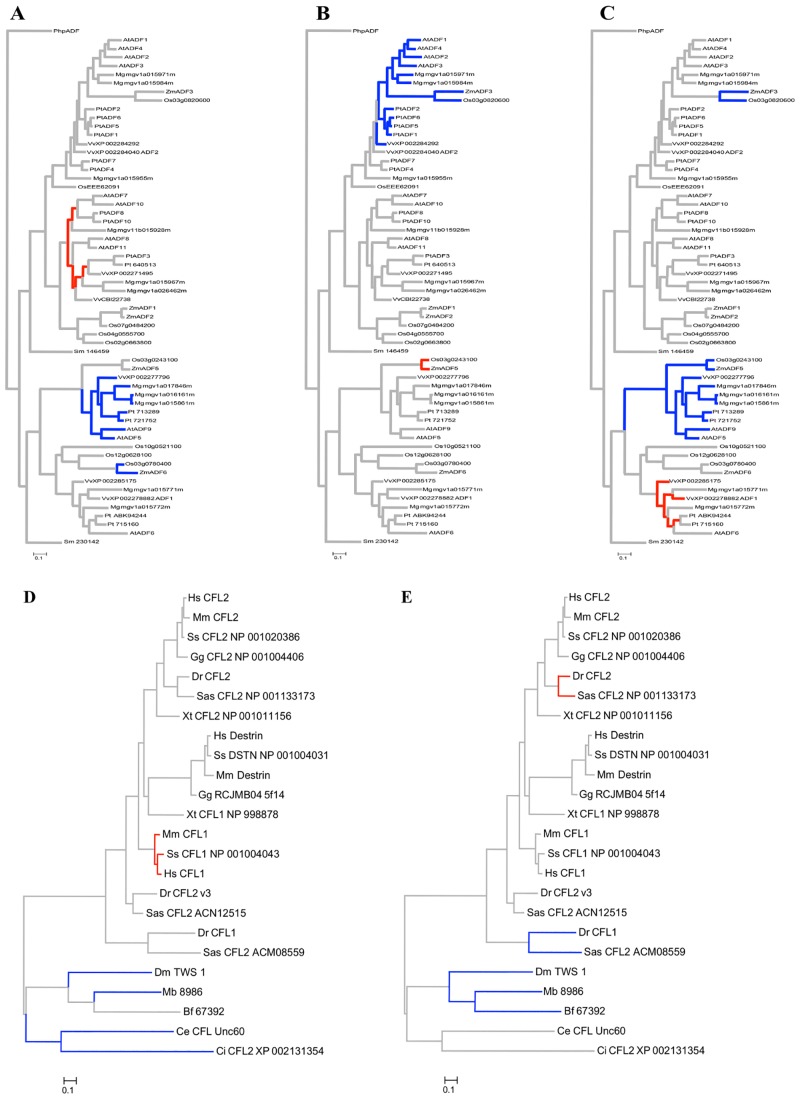
Codon positions with highest probability of being in the ω3 rate category within plant and animal phylogenies.The codon positions (A) 157 (B) 26 and (C) 9 were found to be in the ω3 rate category in the plant ADF phylogeny. The codon positions (D) 125 and (E) 69 were found in the ω3 rate category in the animal ADF/CFL phylogeny. Red branches have the highest probability of being in the ω3 rate category, gray branches represents branches with the highest probability in the ω2 rate category, and blue branches represents branches with the highest probability of being in the ω1 rate category.